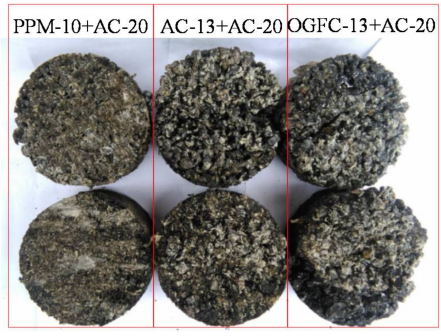
Figure 5. Appearance of fracture surface after shear test for composite specimens without adhesive materials.